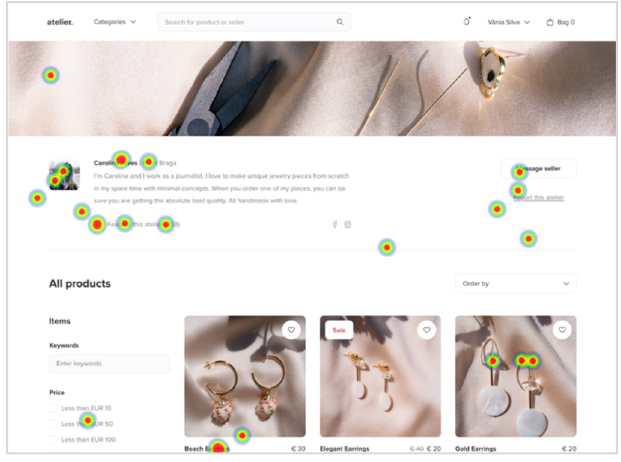
Figure 10. Heatmap. Self-source, 2020.